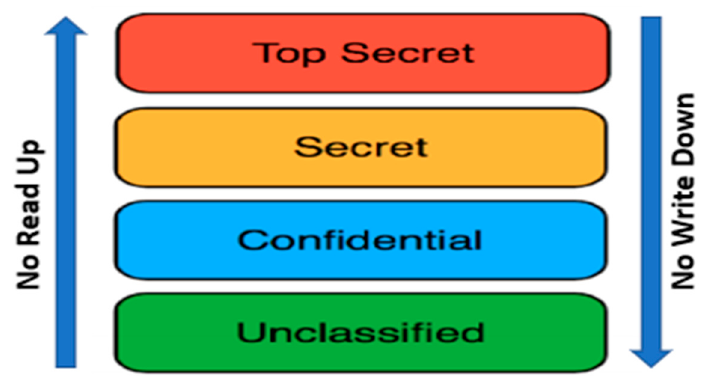
Figure 3. Bell-LaPadula model.